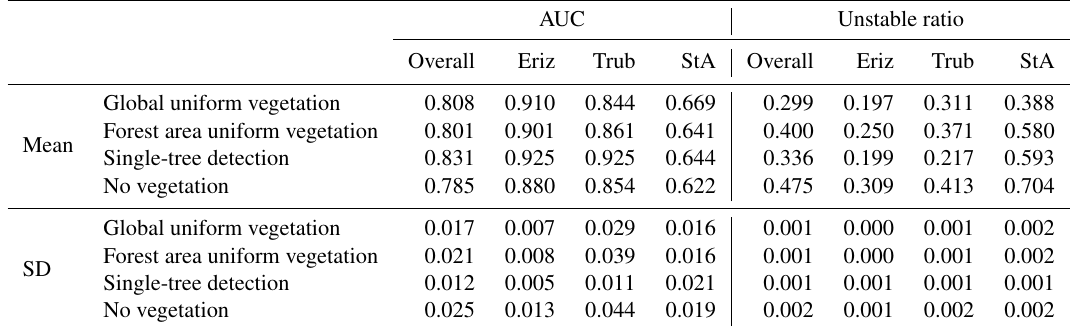
Table 8. The AUC and unstable ratio under different vegetation scenarios with the optimal parameter sets of Table 7 and averaged over 10 runs. “Overall” is composed of the mean value of all three study areas. In the global uniform-vegetation scenario, the reference scenario is used during parameter optimization.